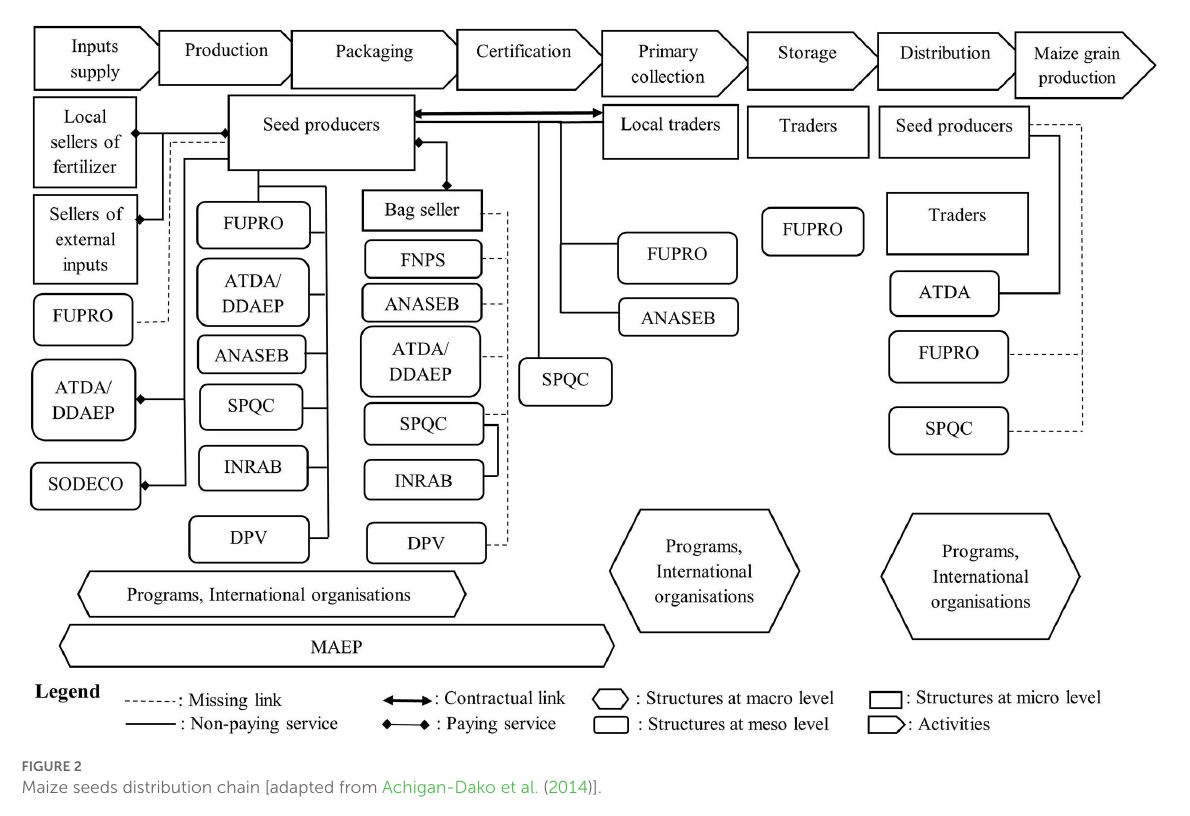
FIGURE2 Maize seeds distribution chain [adapted from Achigan-Dako et al. (2014)].